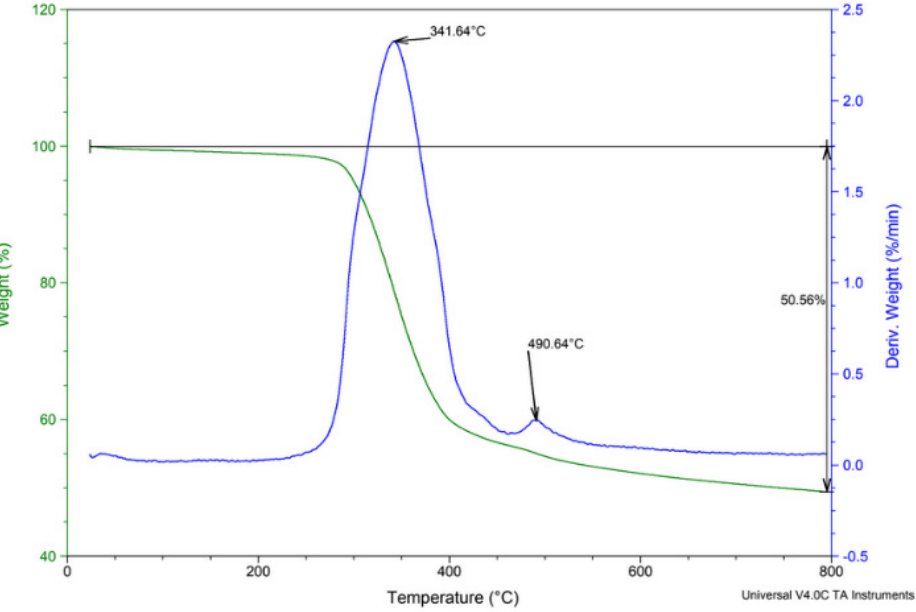
Figure 4. TG and DTG curves of the pyrolysis of the NC2 fraction.